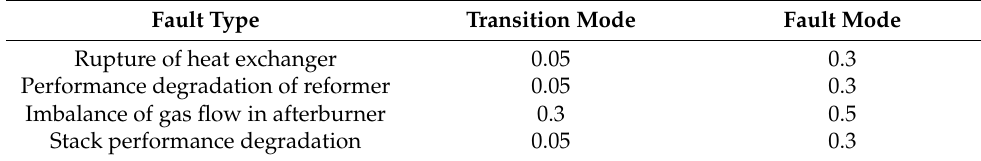
Table 2. Transition and fault mode degradation coefficient for SOFC system typical faults.